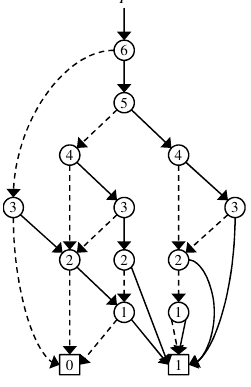
Figure 1. Example of